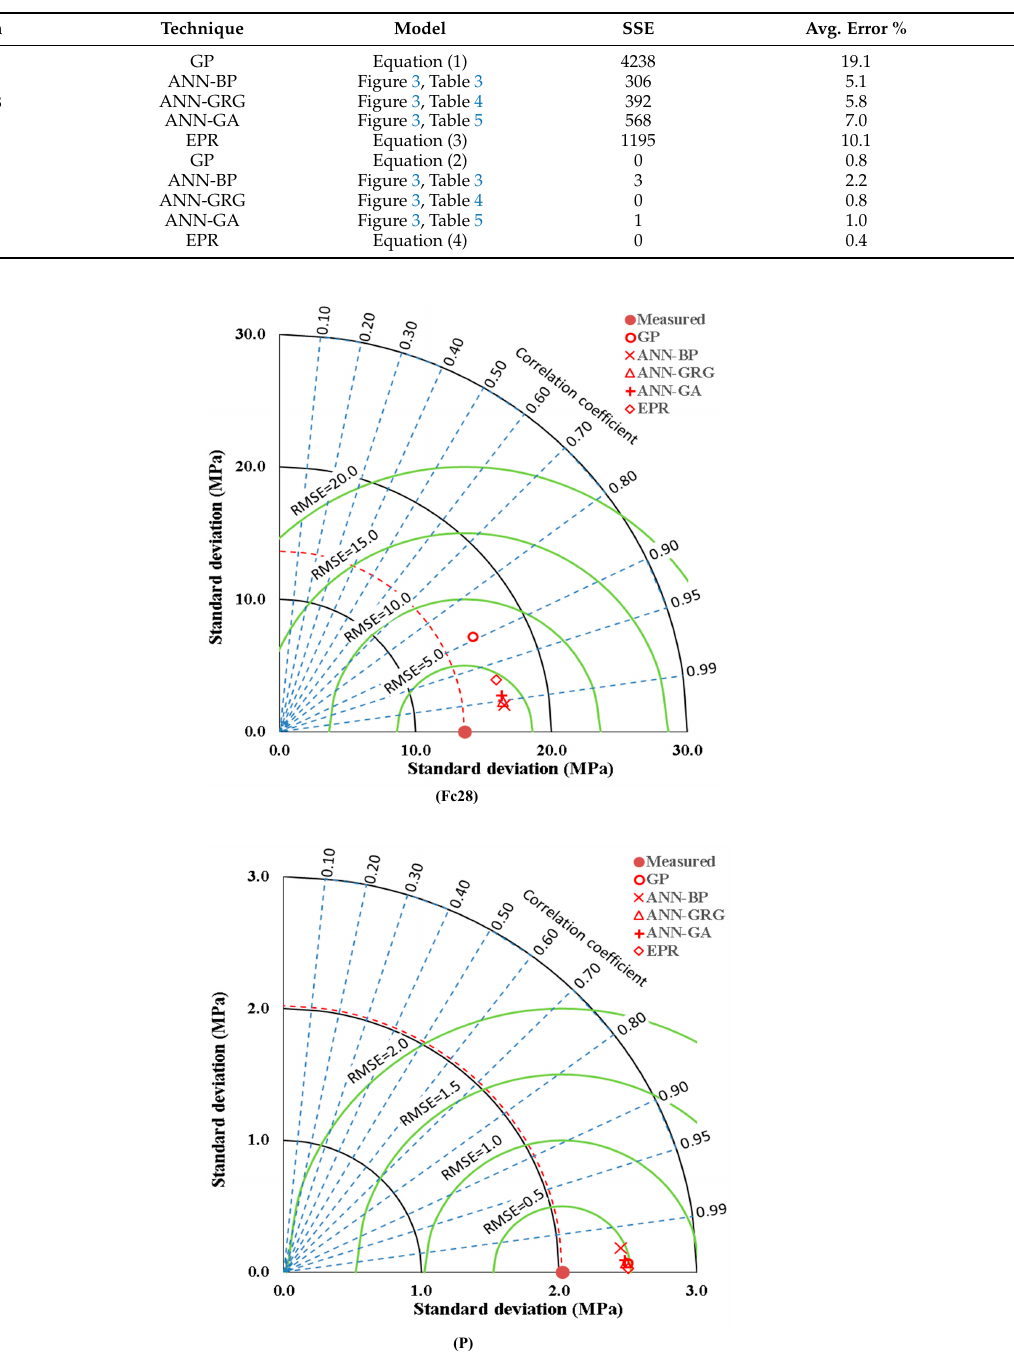
Table 7. Performance and accuracies of the developed models.